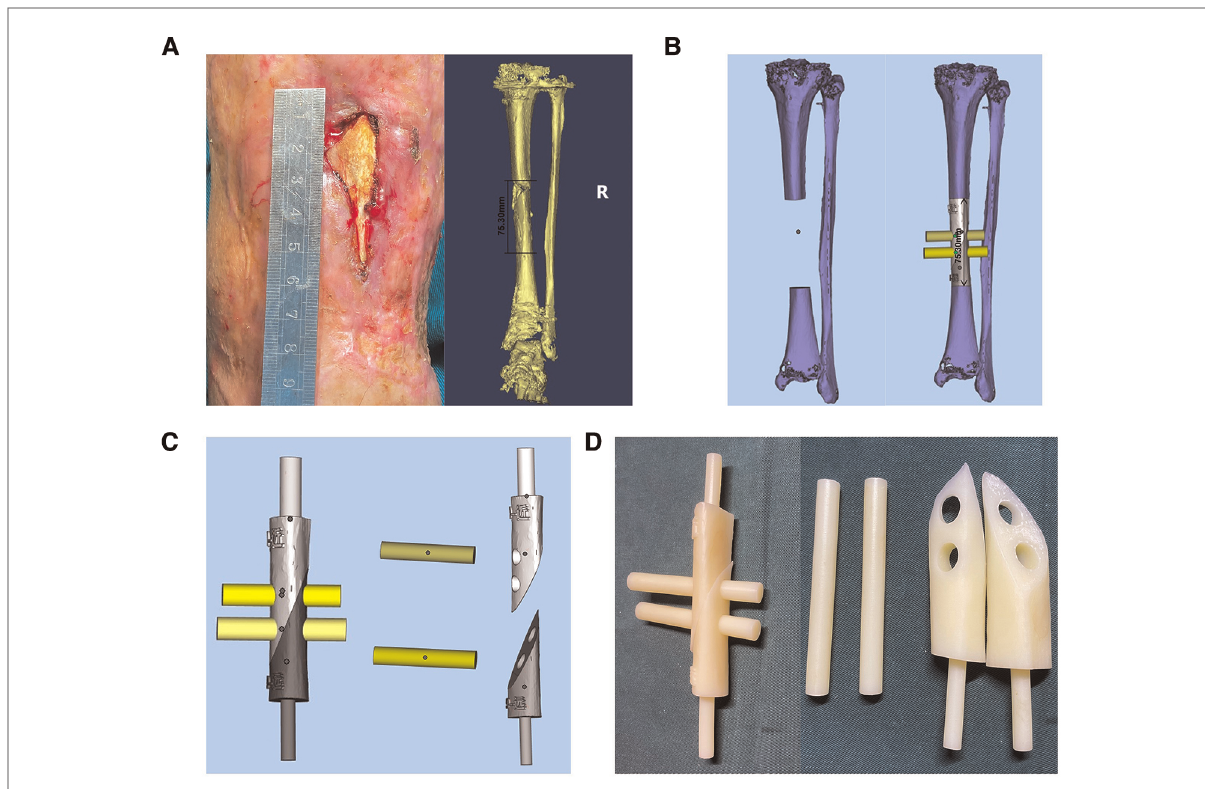
FIGURE 6 The exposure of sequestrum before operation and the design of PSI in case 2. ( A ) The patient ’ s sequestrum was exposed before operation and the designed length of osteotomy was approximately 75.3 mm. ( B ) 3D bone model of affected limb in case 2, the length of bone defect is 75.30 mm. ( C ) The design of PSI. ( D ) The PSI of case 2.